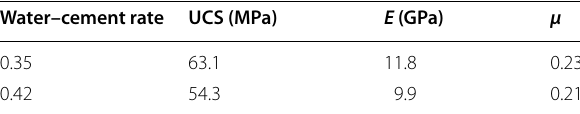
Table 1 Experimental UCS test